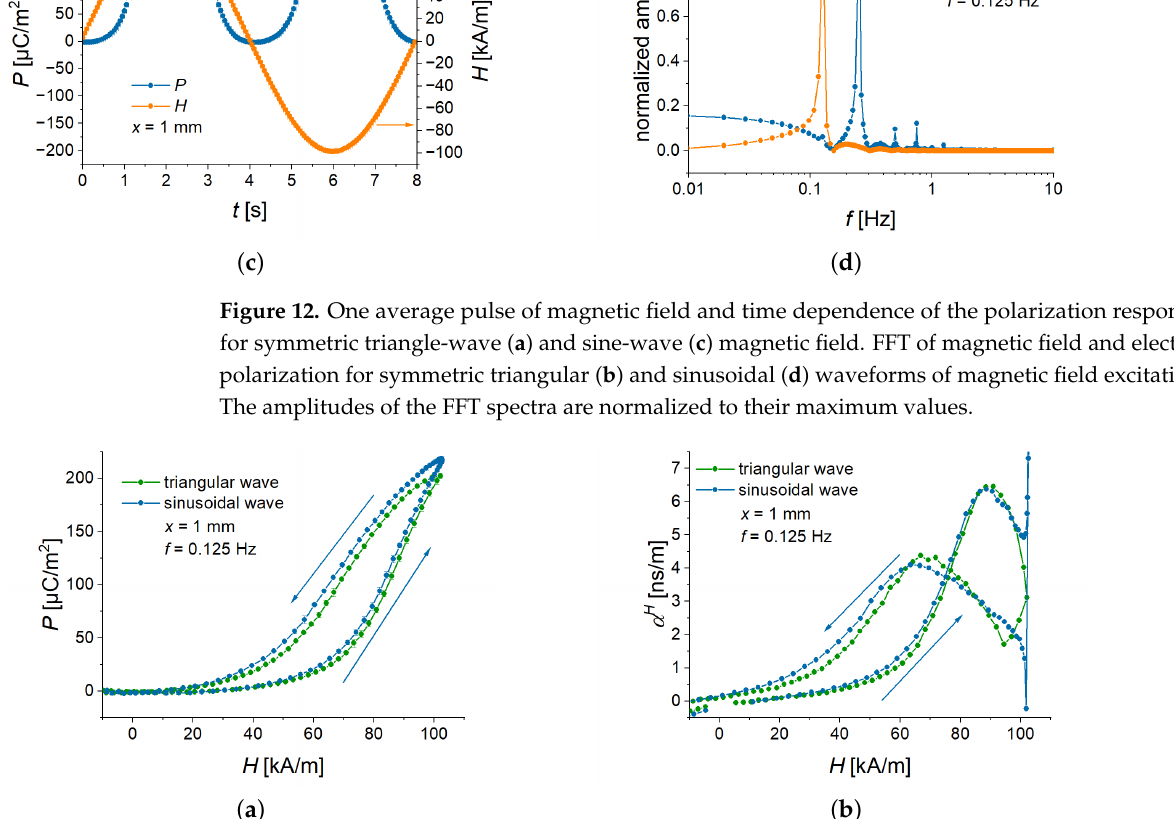
Figure 13. Comparison of field dependences of the polarization ( a ) and the ME coupling coefficient ( b ) for two different magnetic-field excitations. Symmetric triangular and sinusoidal waves have a frequency of 0.125